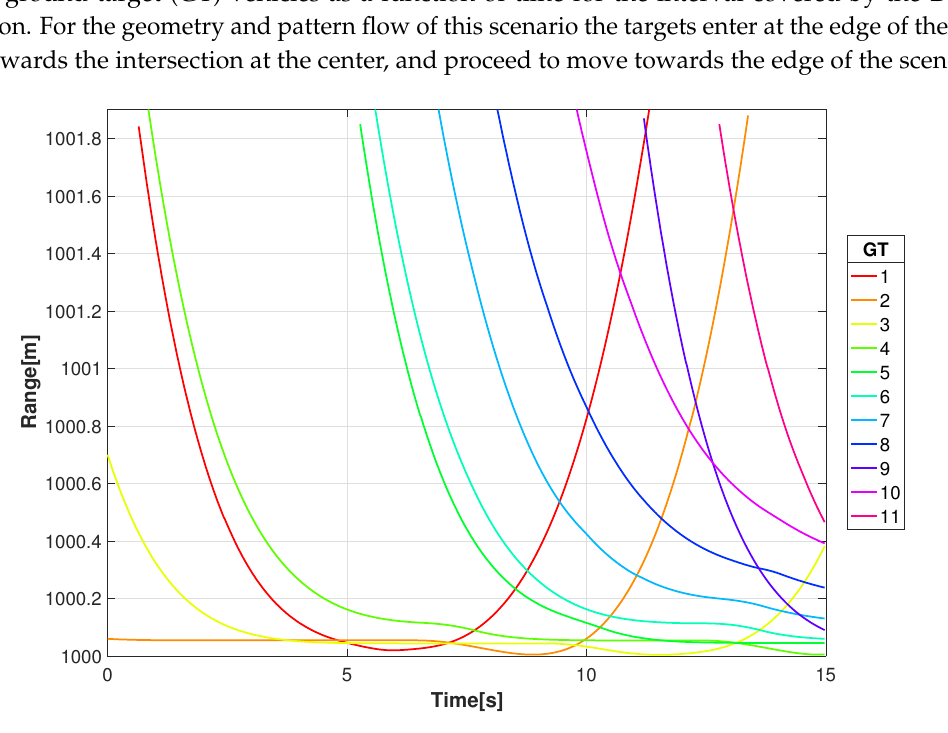
Figure 5. Range of the moving ground targets from the video sensor for the given video